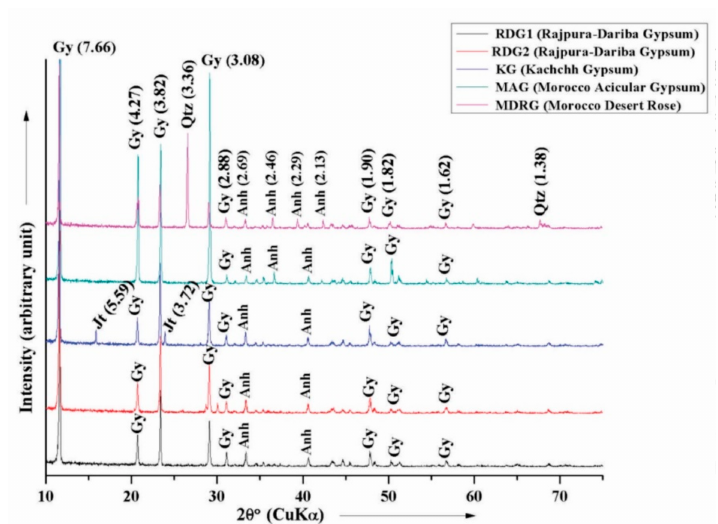
Figure 3. Powder X-ray di ff raction (XRD) patterns of di ff erent gypsum samples showing the presence of gypsum (Gy; d = 7.66, 4.27, 3.82 and 3.08 Å), anhydrite (Anh; d = 2.69, 2.46 and 2.29 Å), quartz (Qtz; d = 3.36 Å), and jarosite (Jt; 5.59 and 3.72 Å).